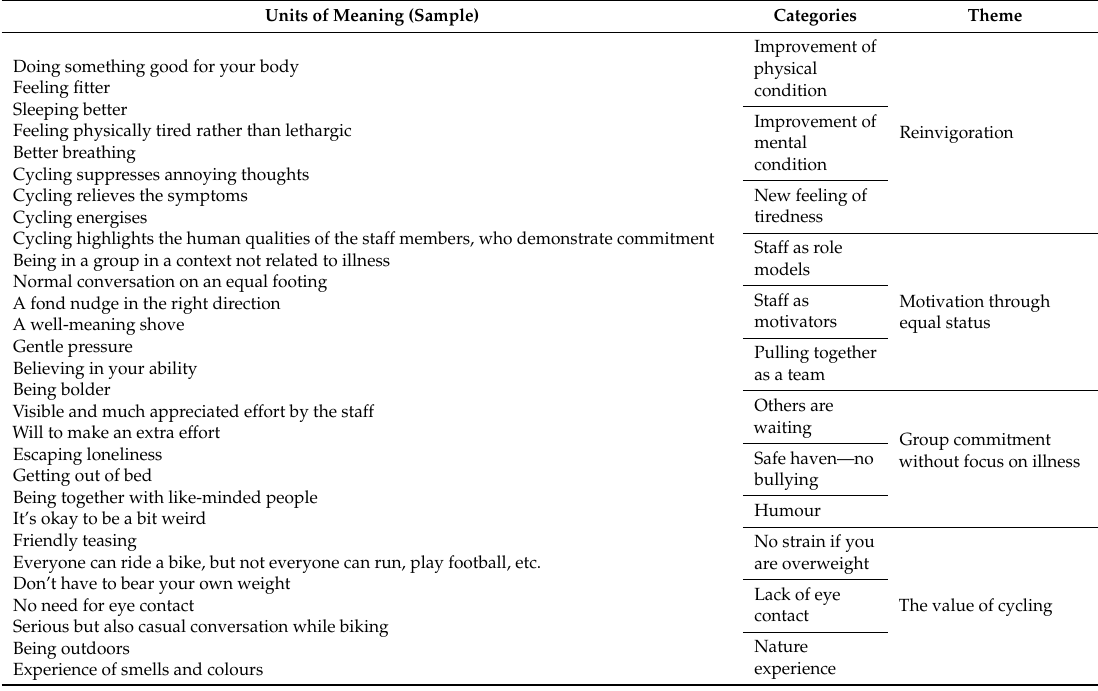
Table 2. Overview of the analysis and